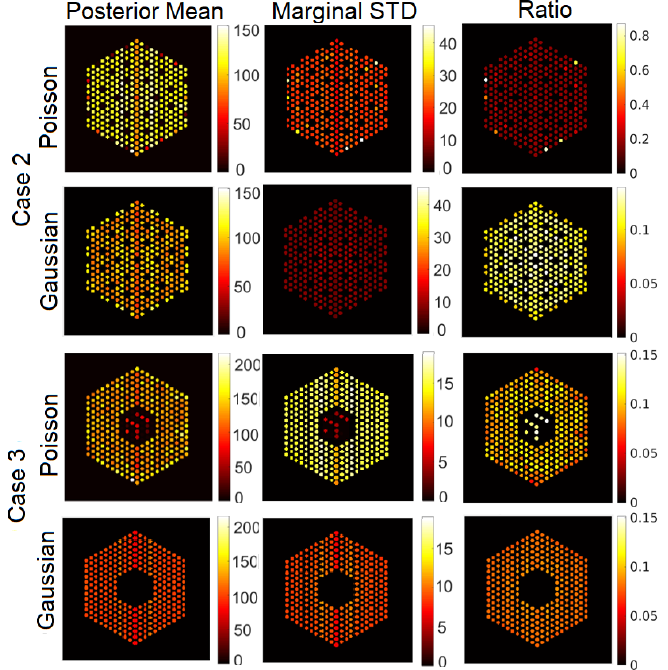
Figure 17. The FULL response matrix: pin pixels averaging of the proposed approach for Case 2 “Uniform Missing Assembly” and Case 3 “Center Missing Assembly”. ( Left-hand column ): posterior mean; ( middle column ): marginal standard deviation (in log-scale); and ( right-hand column ): the ratio of marginal standard deviation divided by posterior mean.